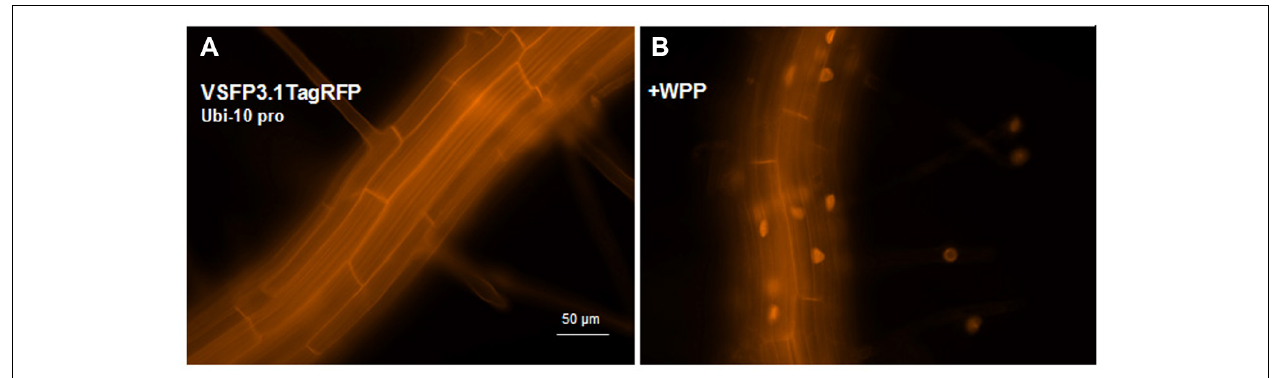
plasma membrane.The four faint spots to the right in (B) are root hair nuclei.The excitation and emission wavelengths ofTagRFP are 545 nm and 605 nm, respectively. Images shown are fluorescence wide field images acquired after focusing on the top cell layers of the root or the root hair.